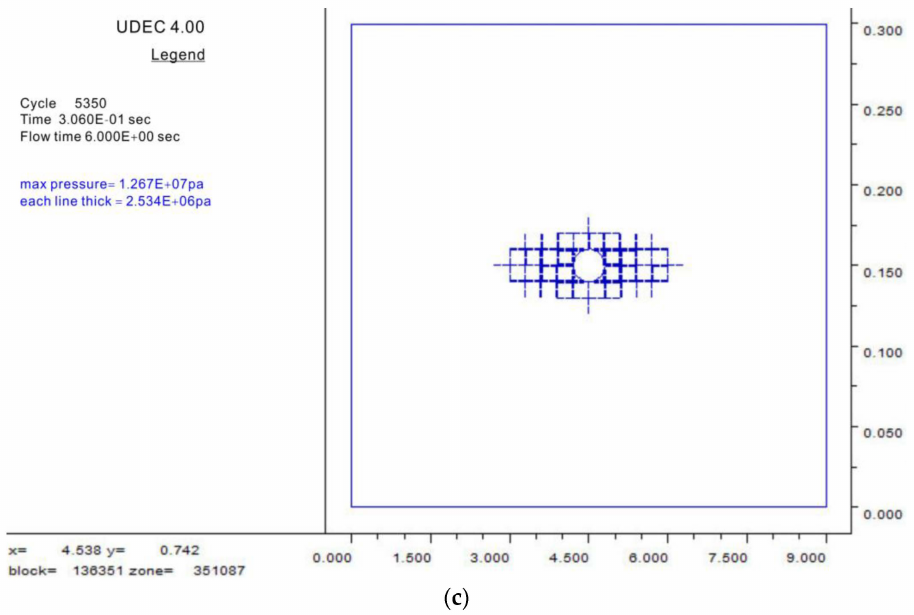
Figure 4. The hydraulic fracturing characteristics at 6 s. ( a ) Fracture geometry; ( b ) Injection pressure curve; ( c ) Distribution of pore pressure.